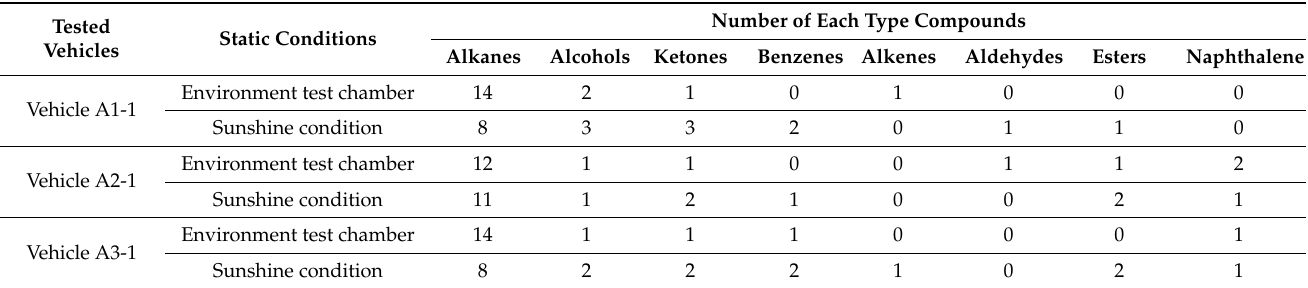
Table 2. Types of the top 18 VOCs identified in interior air samples of Brand A (excluding benzene, toluene, xylene, ethylbenzene, styrene, butyl acetate and